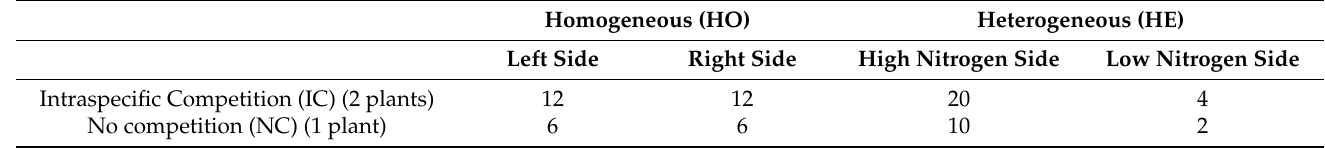
Figure 1. Schematic representation of nutrient distribution patterns and crop cropping patterns. ( a ) Homogeneous with no competition (NCHO); ( b ) Homogeneous with intraspecific competition (ICHO); ( c ) Heterogeneous with intraspecific competition (ICHE); ( d ) Heterogeneous with no competition (NCHE). The brown dots in the pots represent the amount of nitrogen applied. Table 1. Nitrogen application amounts of the different treatments